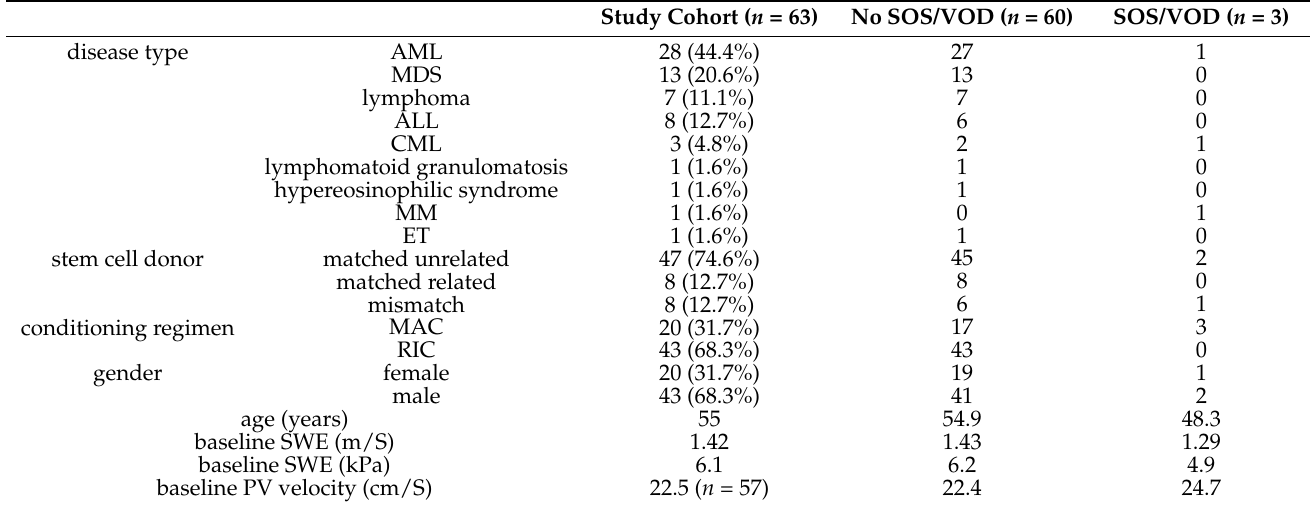
Table 1. Patient